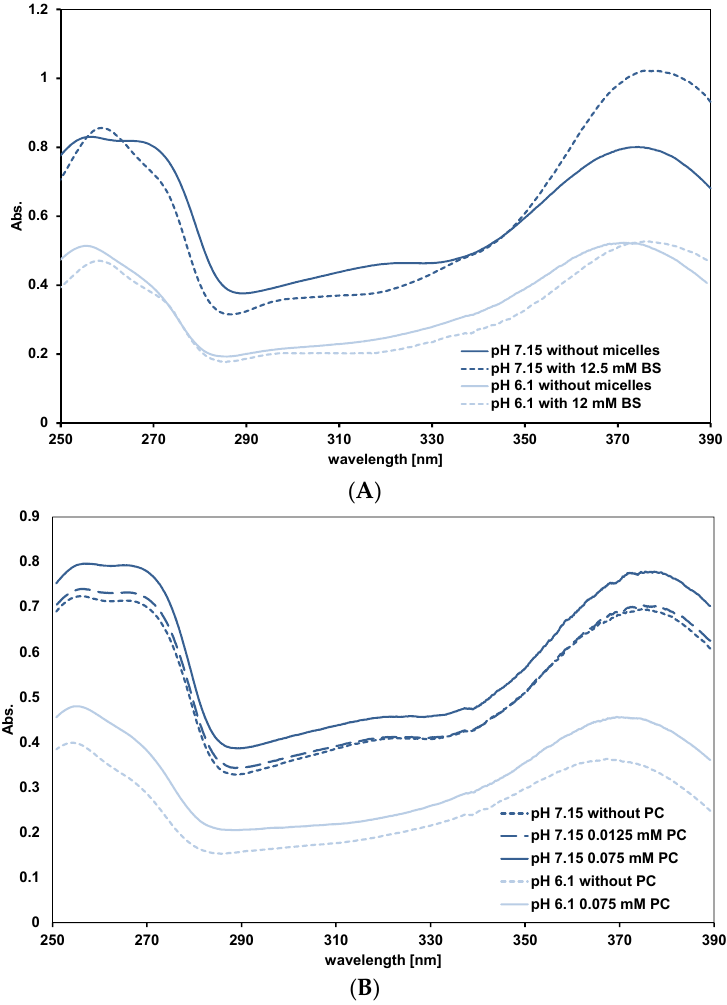
Figure 4. UV ‐ visible spectra of quercetin in micellar solutions FE 2:1 ( A ) and PC liposomes ( B ). In ( A ) the PC and OA concentrations relative to the BS concentrations are as in Table 1.